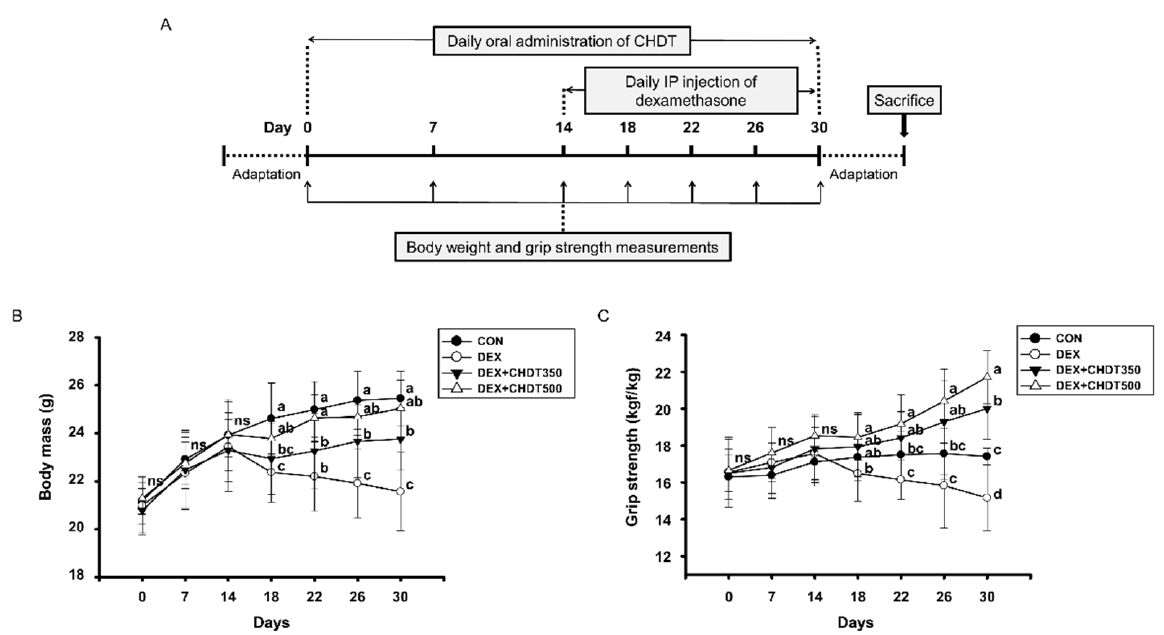
Figure 2. Effects of CHDT on the body mass and muscle strength of mice with Dex-induced muscle atrophy. ( A ) Experimental protocol. CHDT was orally administered daily to 6-week-old mice for 30 days, and from 14 days after the start of administration, Dex was IP injected daily. ( B ) Body mass and ( C ) grip strength of the mice were measured on days 0, 7, 14, 18, 22, 26, and 30. “ns” indicates that there was no statistically significant difference between all groups. ( p > 0.05). Different letters indicate statistically significant differences; p < 0.05, a > b > c > d.